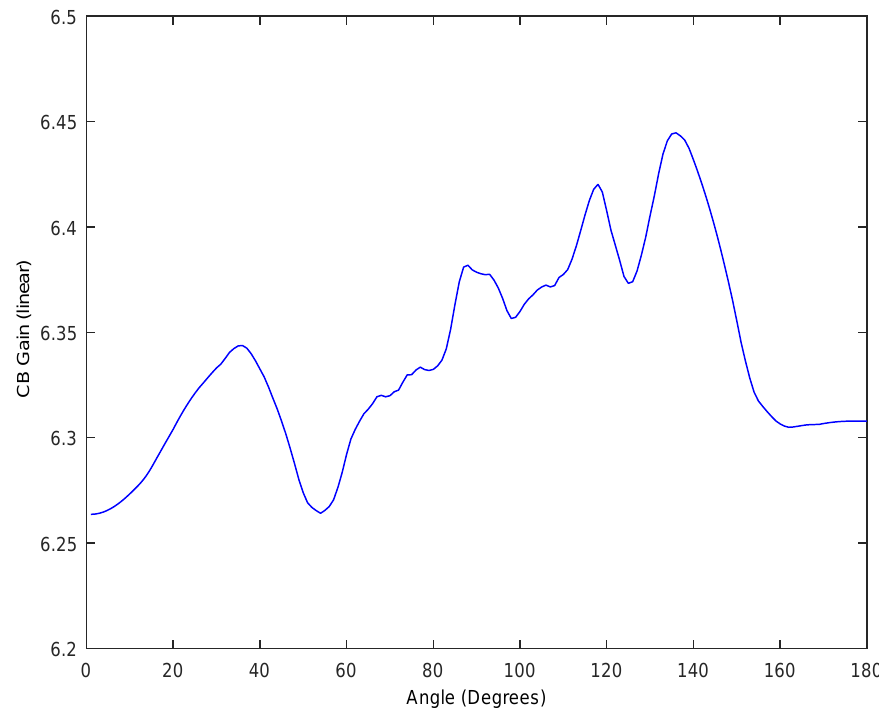
Figure 13. Average value of the planar 2D uniform array pattern calculated following a MC simulation M = 10 3 with φ = 0 ◦ and 0 ◦ < θ < 180 ◦ for 900